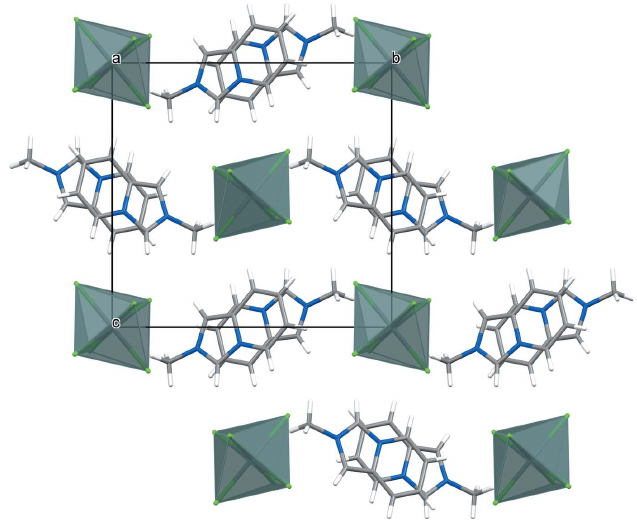
Figure 1 Molecular structure of (I) with atom labelling showing 50% displacement ellipsoids. [Symmetry code: (i) (cid:5) x + 1, (cid:5) y + 1, (cid:5) z + 1.]